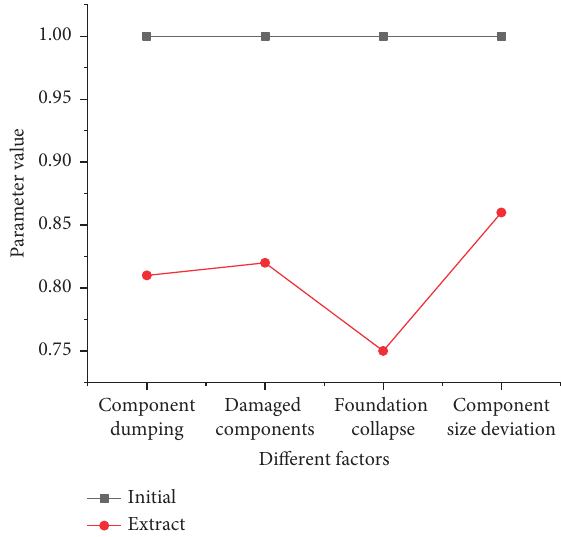
Figure 10: Data diagram of common factor variance of risk index of prefabricated building